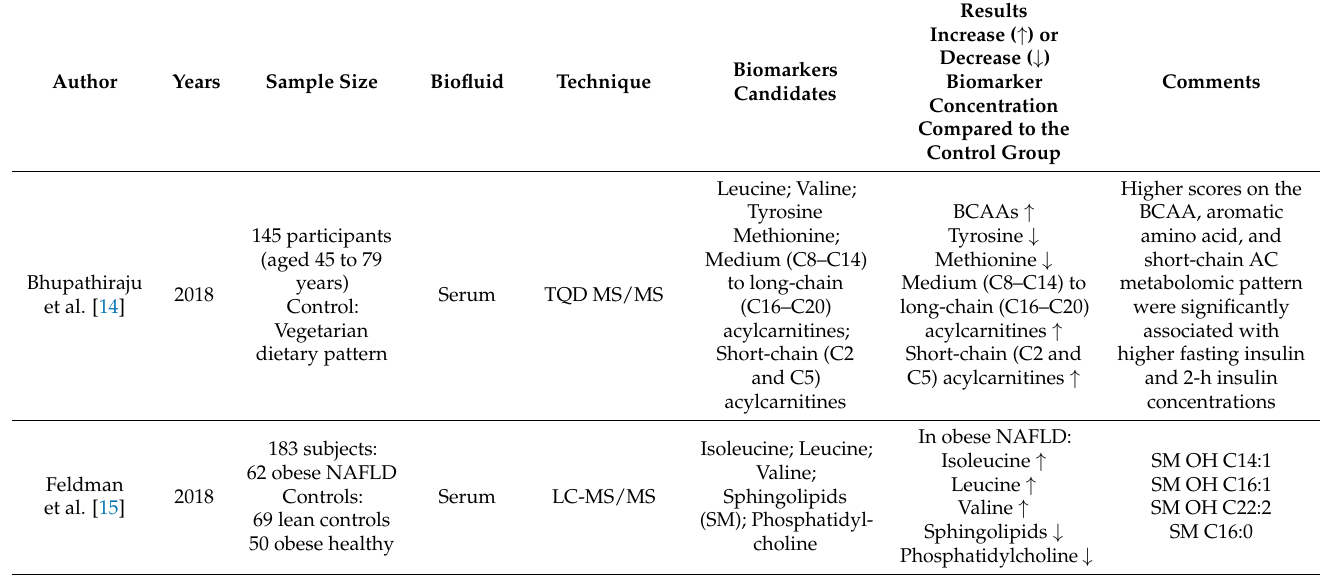
Table 2. Selected Characteristics of Reviewed Studies on the Metabolomics of NAFLD and NASH